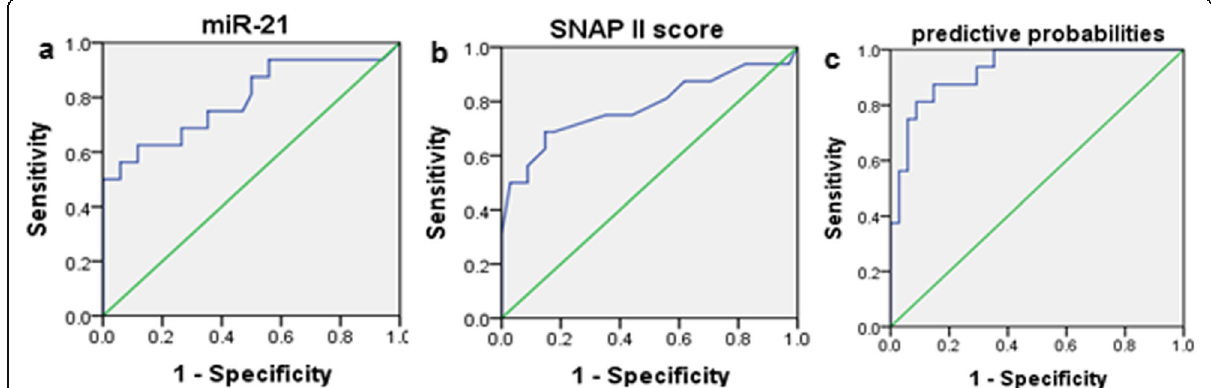
Fig. 4 ROC analyses of miR-21 expression levels (2 −Δ Ct ), SNAP II, and predictive probabilities for sepsis survivors and non-survivors. Predictive probabilities calculated from the multivariate logistic regression analysis for the combination of miR-21 levels and SNAP II